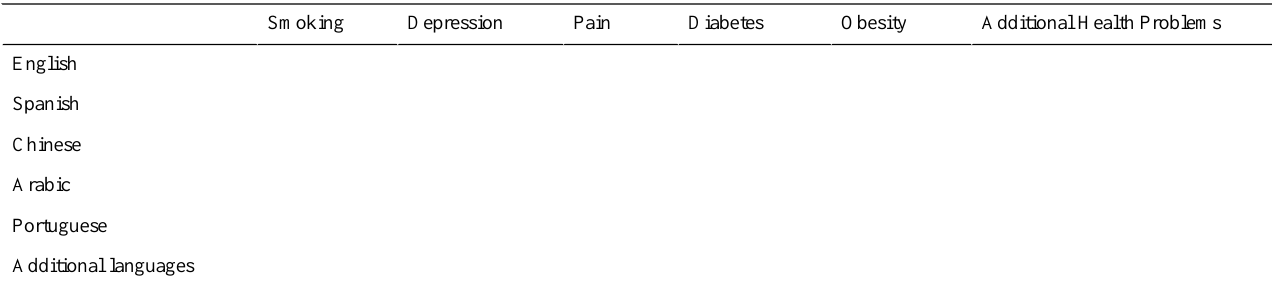
Table 1. Matrix for systematic development of evidence-based Web interventions: health problems by languages (our goal is to fill this